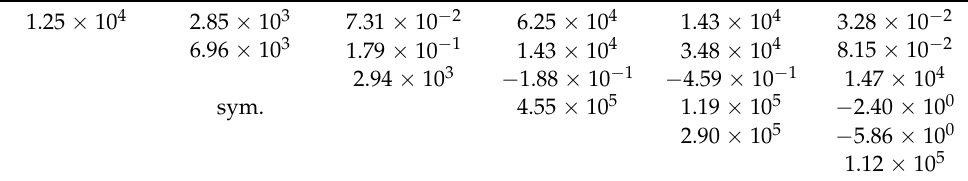
Table 1. Equivalent stiffness of the triangle HSP (unit: